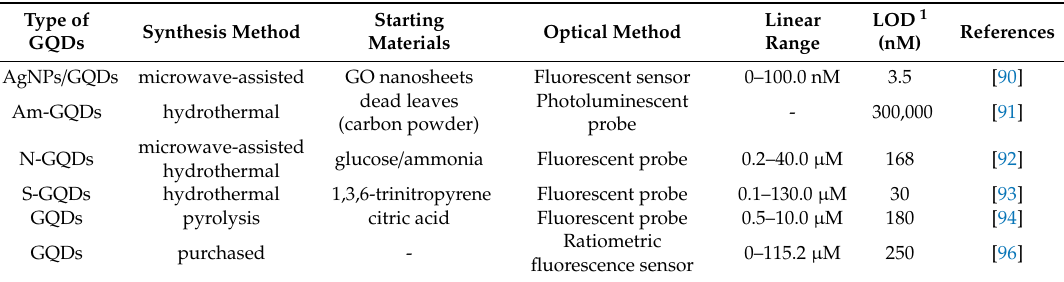
Table 6. The GQDs-based optical sensor for silver ion